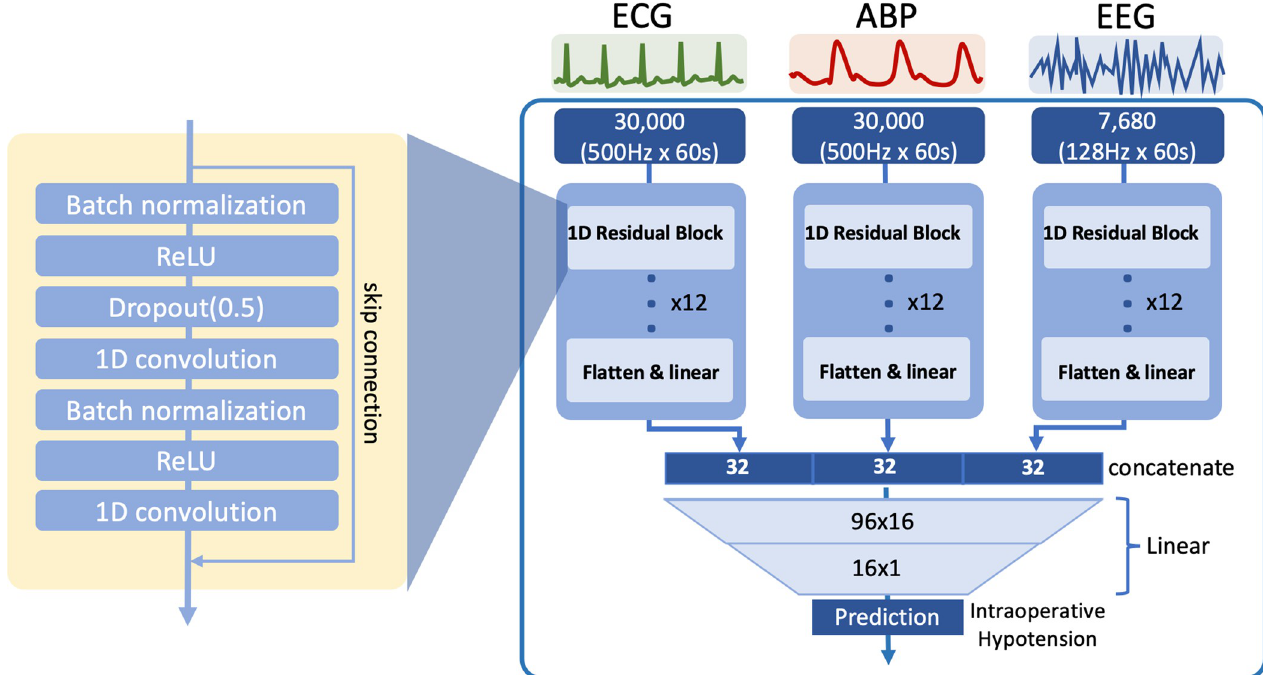
Fig 2. Architecture of the hypotension risk prediction model using multiple